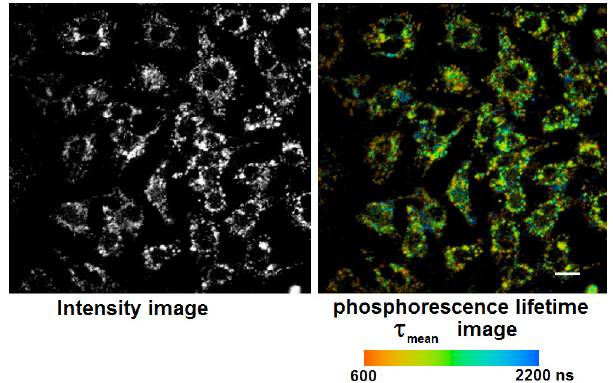
Fig. 3. PLIM of IEC-6 monolayer cells of the 615 – 690 nm spectral channel after excitation with fs pulsed laser at 250 MHz repetition rater: Intensity image (left) and in false colors, the phosphorescence mean lifetime in the range from 600 ns to 2200 ns (right); the scale bar corresponds to 20 (cid:3)